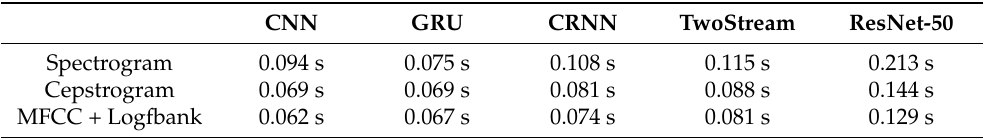
Table 6. The time required for the combination of three audio features and five neural networks to complete the detection of 41 calls of a three-yellow chicken. CNN GRU CRNN TwoStream ResNet-50 Spectrogram 0.094 s 0.075 s 0.108 s 0.115